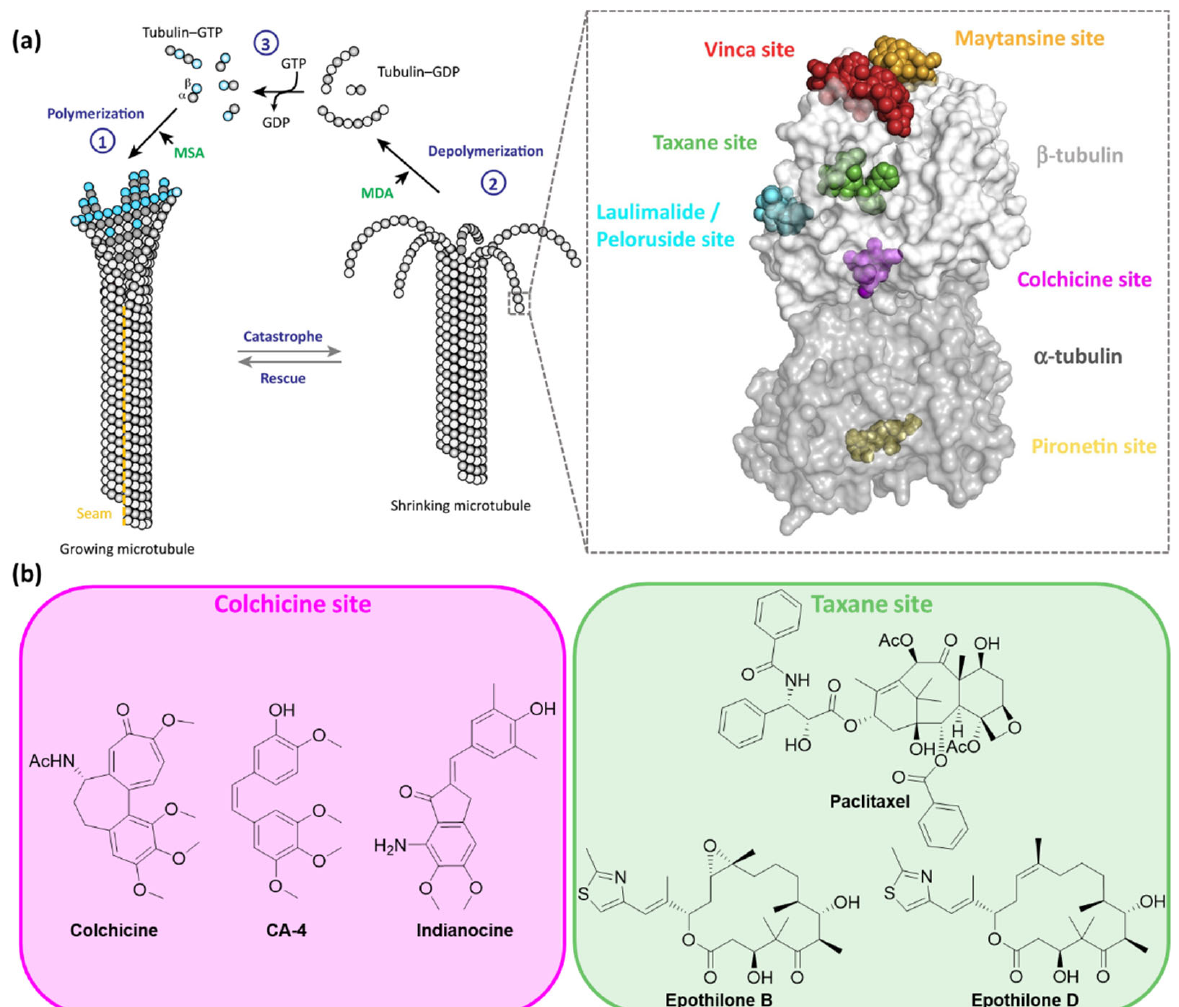
Figure 1. ( a ) The equilibrium of GTP ‐ dependent assembly of α / β‐ tubulin heterodimers is referred to as ‘dynamic instability’. Microtubule stabilizing agents (MSAs) shift the equilibrium towards the microtubule (“1”—polymerization) and microtubule destabilizing agents (MDAs) towards tubulin heterodimers (“2”—depolymerization). The depolymerized fragments are activated (“3”—transesterification) for the following assembly process. Six binding sites of microtubule- targeting agents on tubulin have been identified and are highlighted in green (taxane site), cyan (laulimalide/peloruside site), magenta (colchicine site), slate (vinca site), orange (maytansine site) or yellow (pironetin site). ( b ) Photoswitchable analogues of microtubule destabilizing agents binding to the colchicine site and microtubule stabilizing agents binding to the taxane site have been developed. Adapted with permission from the ref. [2]. Copyrights (2018) Elsevier.